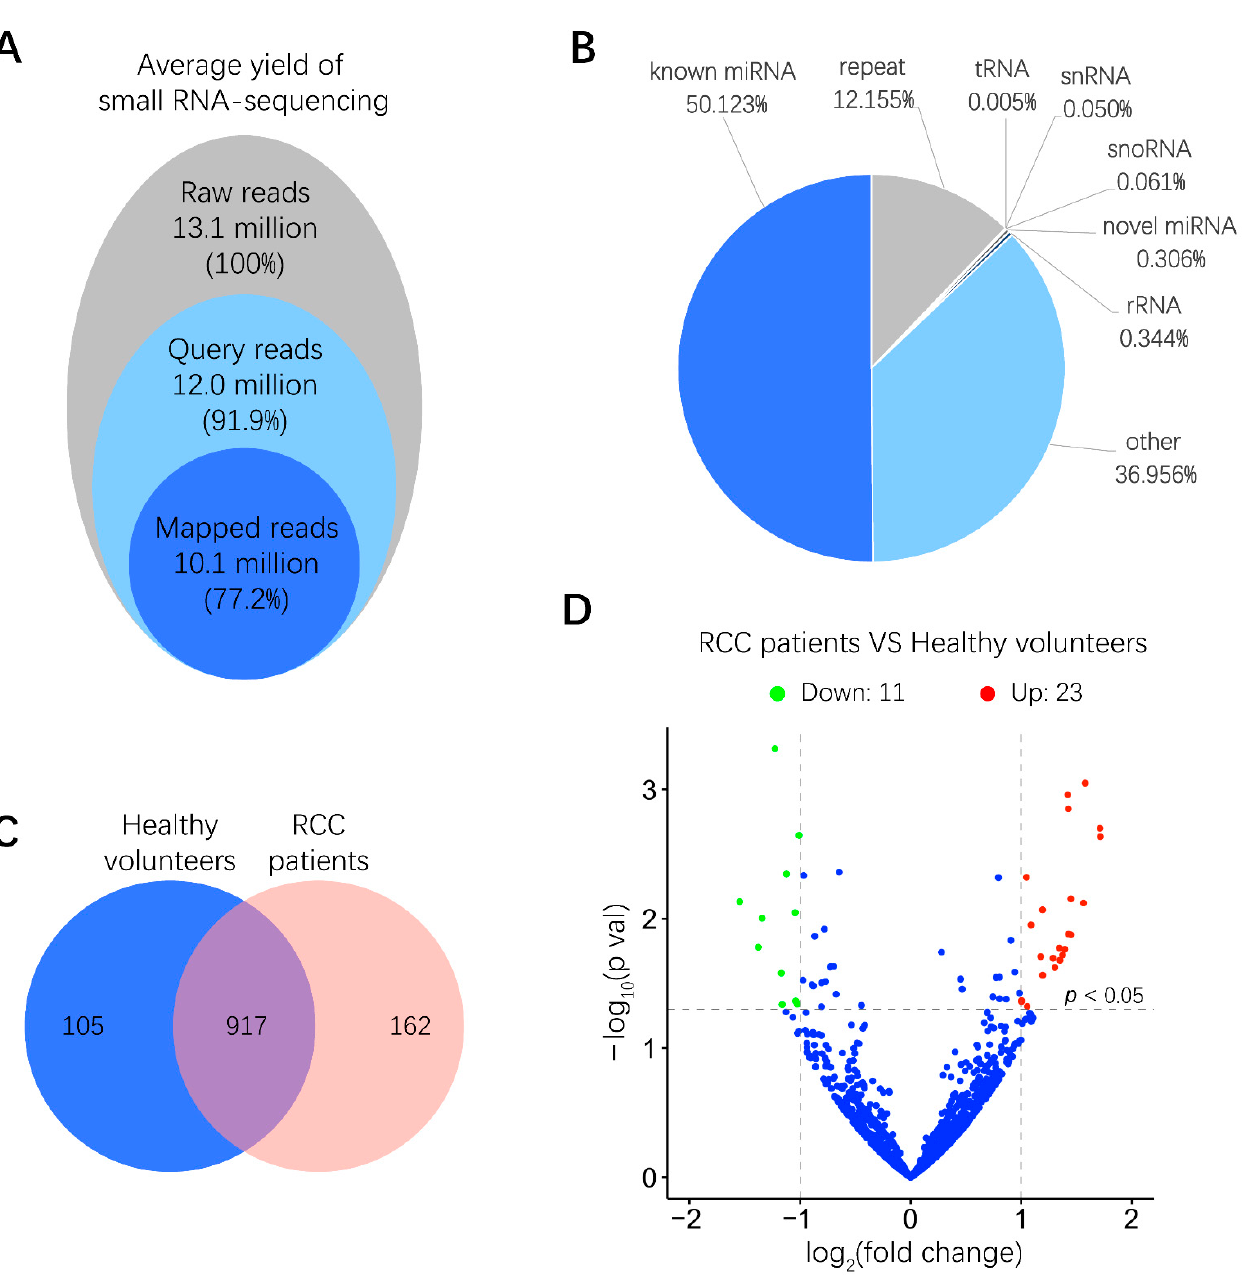
Figure 2. Small RNA sequencing results of miRNA expression levels in human urinary EVs. ( A ) Overview of small RNA- sequencing results including the number and percentage of total reads, query reads and mapped reads. ( B ) Distributions of different non-coding small RNA types in mapped reads. ( C ) Venn diagram of identified common and unique miRNAs in RCC patients and healthy volunteers. ( D ) Volcano plot of differences between miRNAs in urinary EVs were classified according to the fold changes (log 2 (fold change)) between RCC patients (n = 6) and healthy volunteers (n = 6). Green, red and blue dots mean that miRNAs expression have significant downregulation, upregulation and no significant difference in RCC patients compared with healthy volunteers, respectively (|log 2 (fold change)| > 1, p < 0.05).